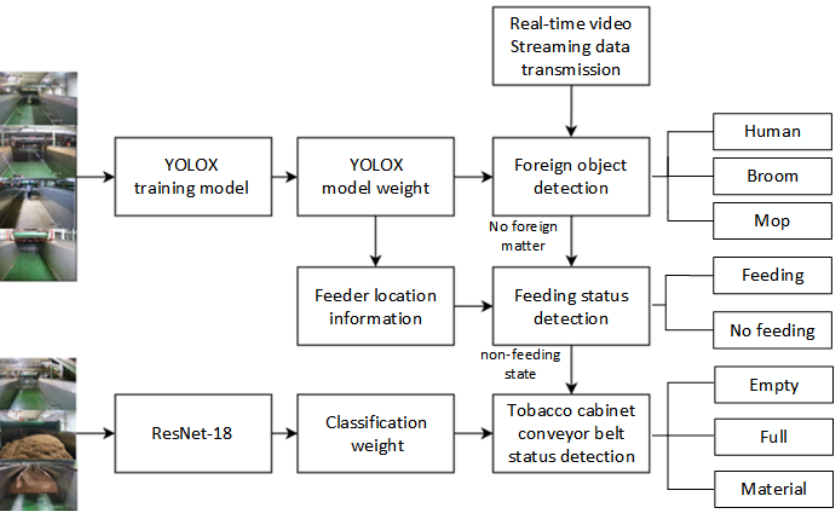
Figure 4. Overview of the proposed approach. The proposed aproach contains three steps: (1) The tobacco cabinet is tested for foreign objects based on the YOLOX. (2) It is judged whether the tobacco cabinet is in the feeding state. (3) If it is not in the feeding state, then based on the ResNet-18 image classification network in deep learning, the three states of empty, full and material status of tobacco on the tobacco cabinet conveyor belt are